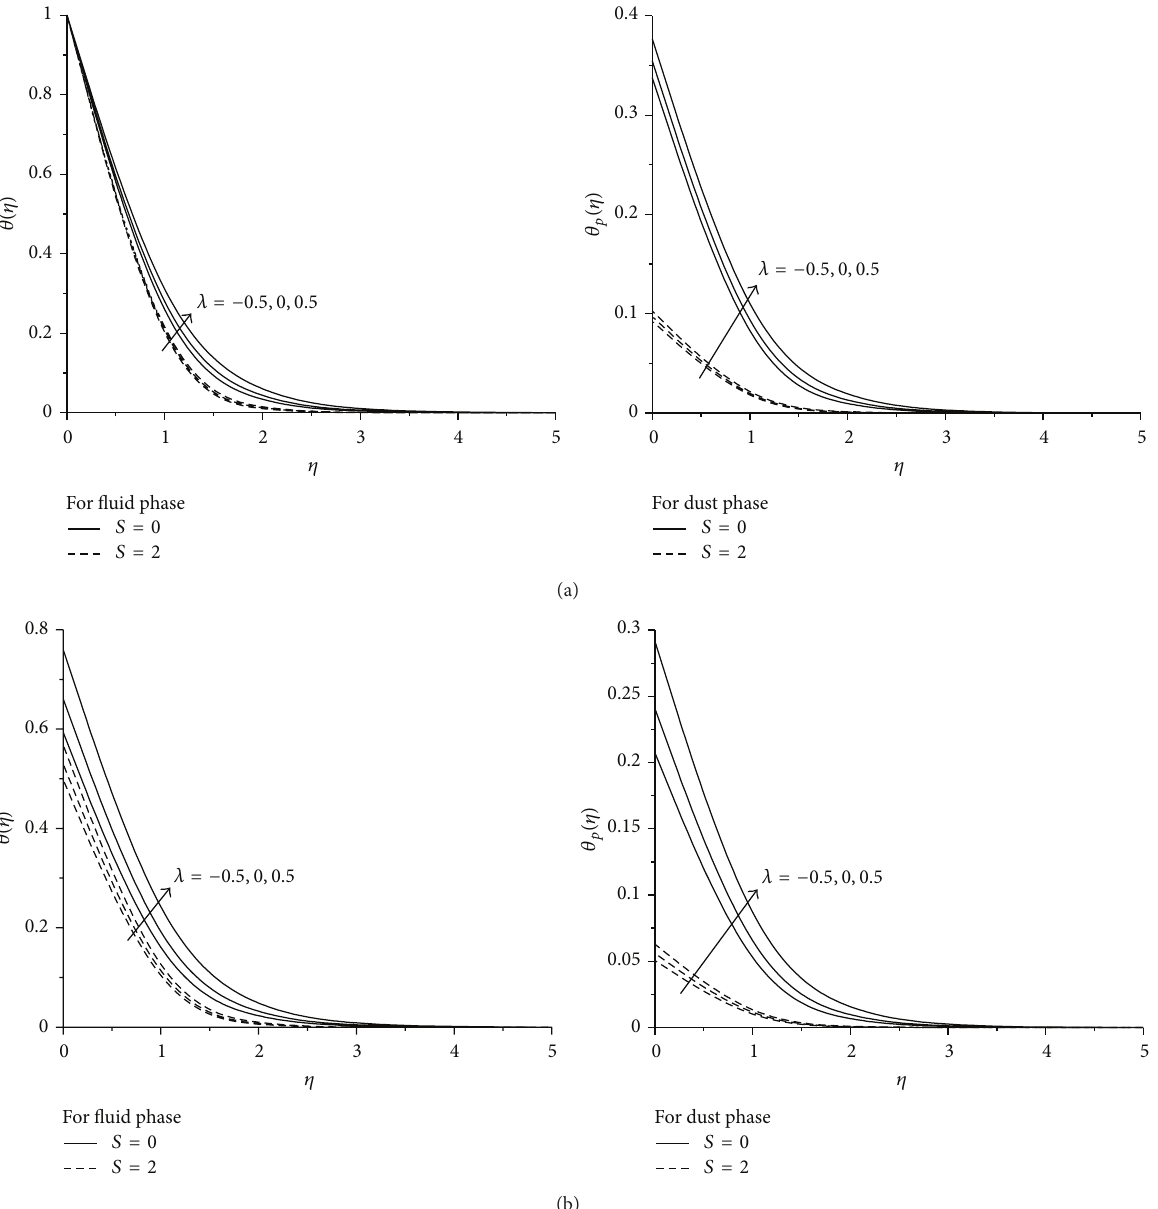
parameter 𝜆 on temperature profiles. As 𝜆 increases,